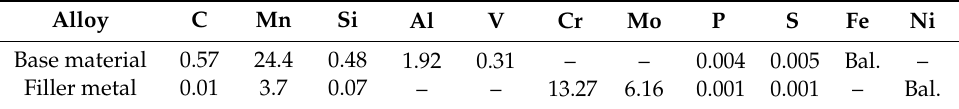
Table 1. Chemical composition of the base material and filler metal in